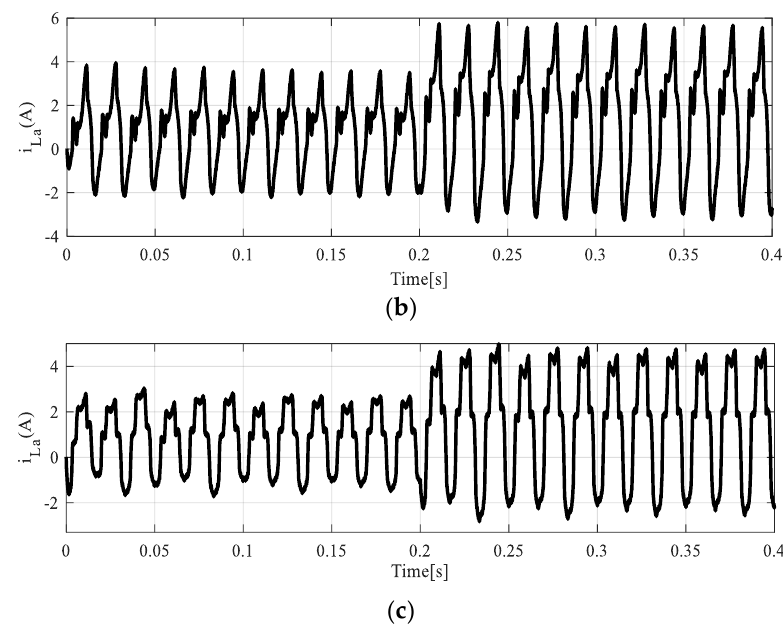
Figure 17. The lower arm currents of phase “a” for the ( a ) first controller, ( b ) second controller, and ( c ) third controller.